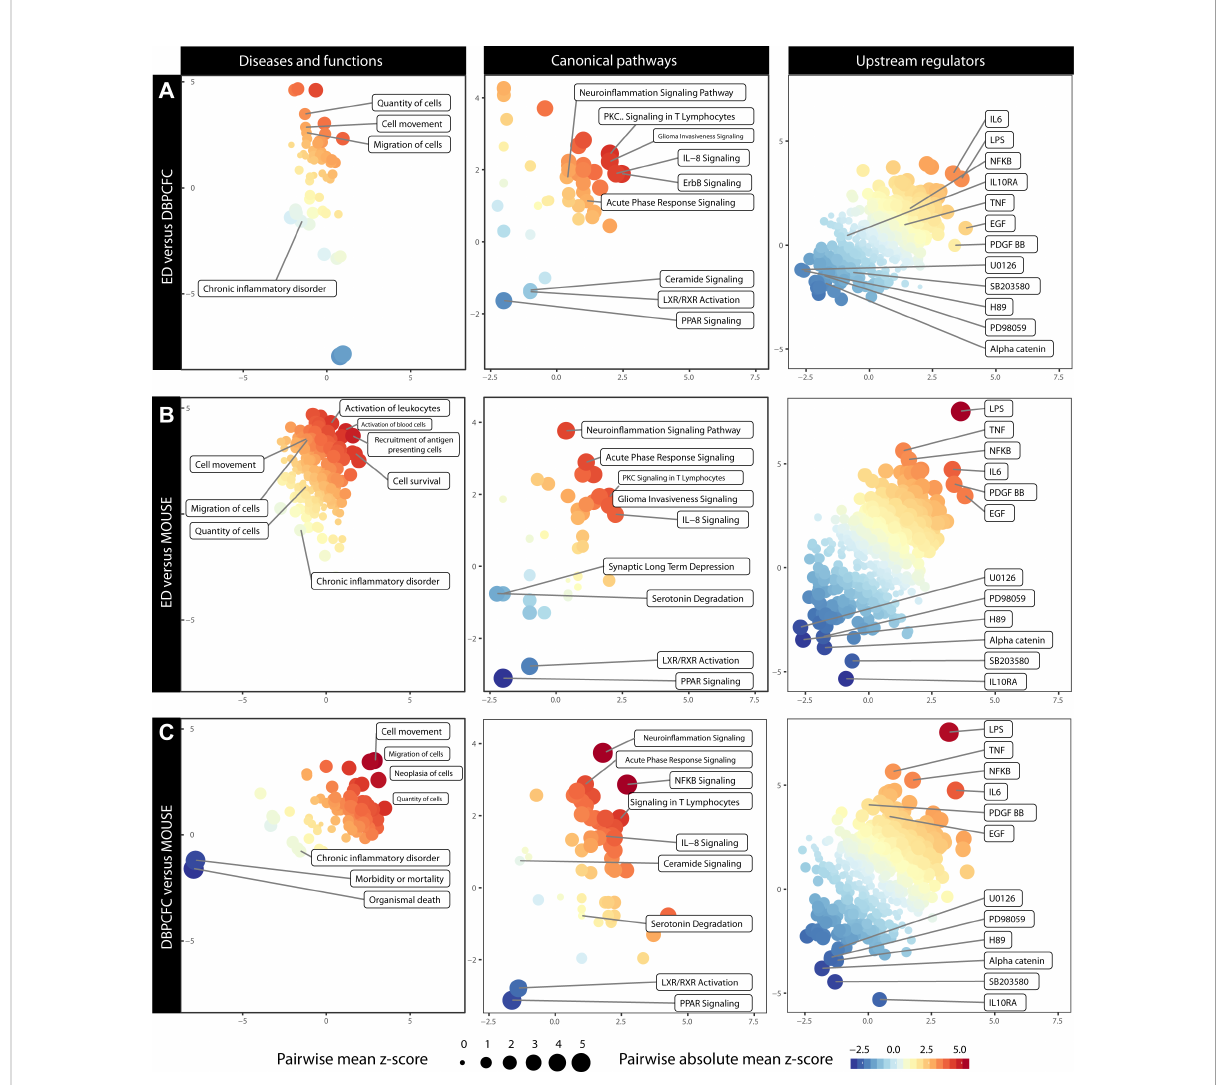
FIGURE 3 Comparison of altered Diseases and functions, Canonical pathways and Upstream regulators during anaphylaxis between different study groups: (A) ED and DBPCFC, (B) ED and MOUSE, (C) DBPCFC and MOUSE. The plot is based on the z score calculations obtained for a given set of genes using the IPA analysis. The positive values indicate an overall upregulation (red colour) of the genes in a set and negative values indicate a downregulation (blue colour). The colour of the points corresponds to a mean of z scores obtained for the pair of exposures in each panel, and the size of the points corresponds to an absolute average of z scores. The larger and more intensely coloured points, therefore, indicate a more pronounced and analogous dysregulation of a gene set in a given pair of exposures. Details in Supplementary Table 8 (Diseases and functions), Supplementary Table 9 (Canonical pathways) and Supplementary Table 10 (Upstream